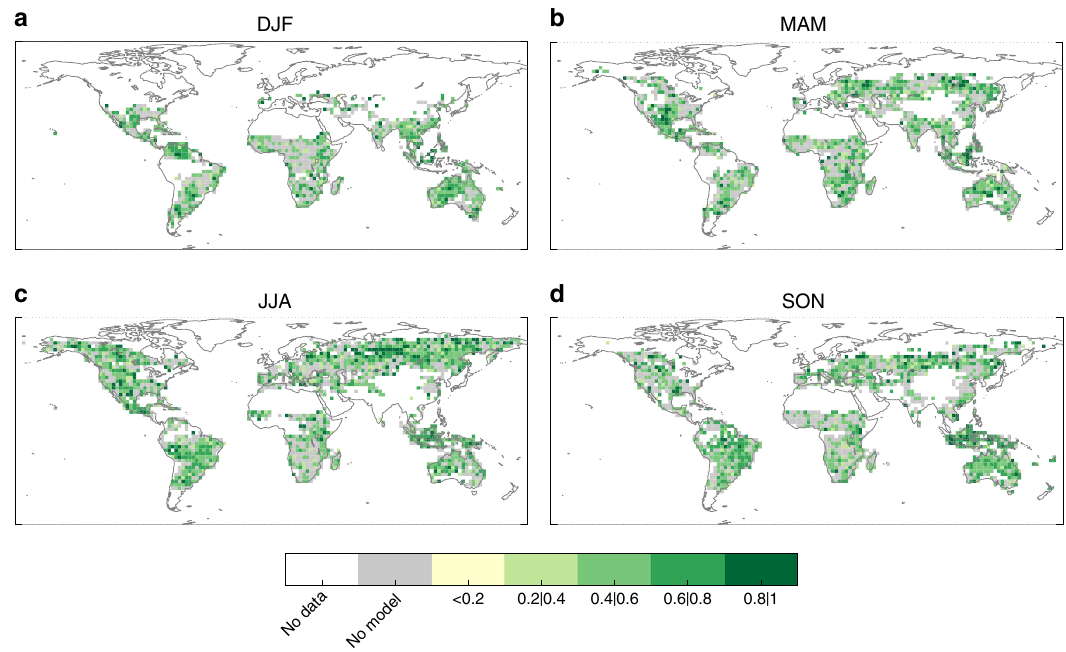
Fig. 2 Maximum skill of burned area predictions obtained using observed climate. Correlations of out-of-sample burned area (BA) predictions using the SPI – BA model fed with observed SPI data for a December – January – February (DJF), b March – April – May (MAM), c June – July – August (JJA) and d September – October – November (SON). Only correlations that are signi fi cant ( p -value < 0.05) are shown in green colours. Grey colour shadows those grid- points with non-signi fi cant correlation values. White indicates areas where fi res do not occur (e.g. sea) or have not been